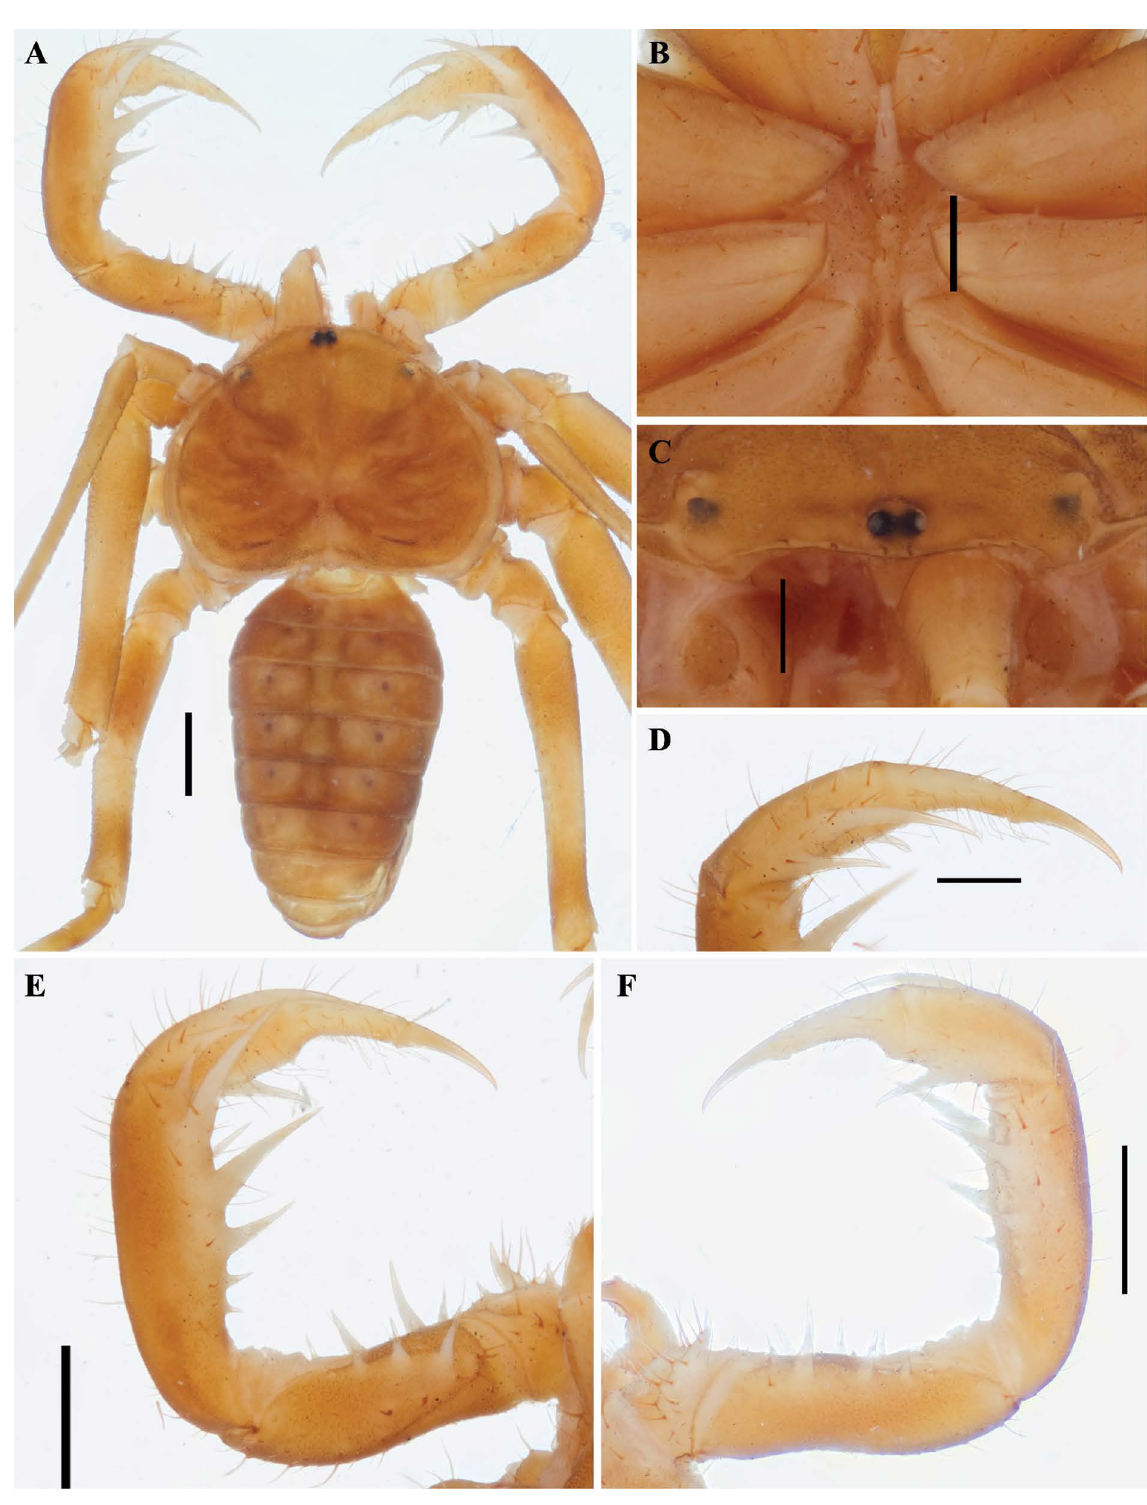
Fig. 117. Sarax lembeh sp. nov. (FMNH 3489485), general morphology, ♀. A . Habitus, dorsal view. B . Sternum, ventral view. C . Frontal process. D . Pedipalp tarsus, frontal view. E . Pedipalp, dorsal view. F . Pedipalp, ventral view. Scale bars: A, E–F = 1 mm; B–D =